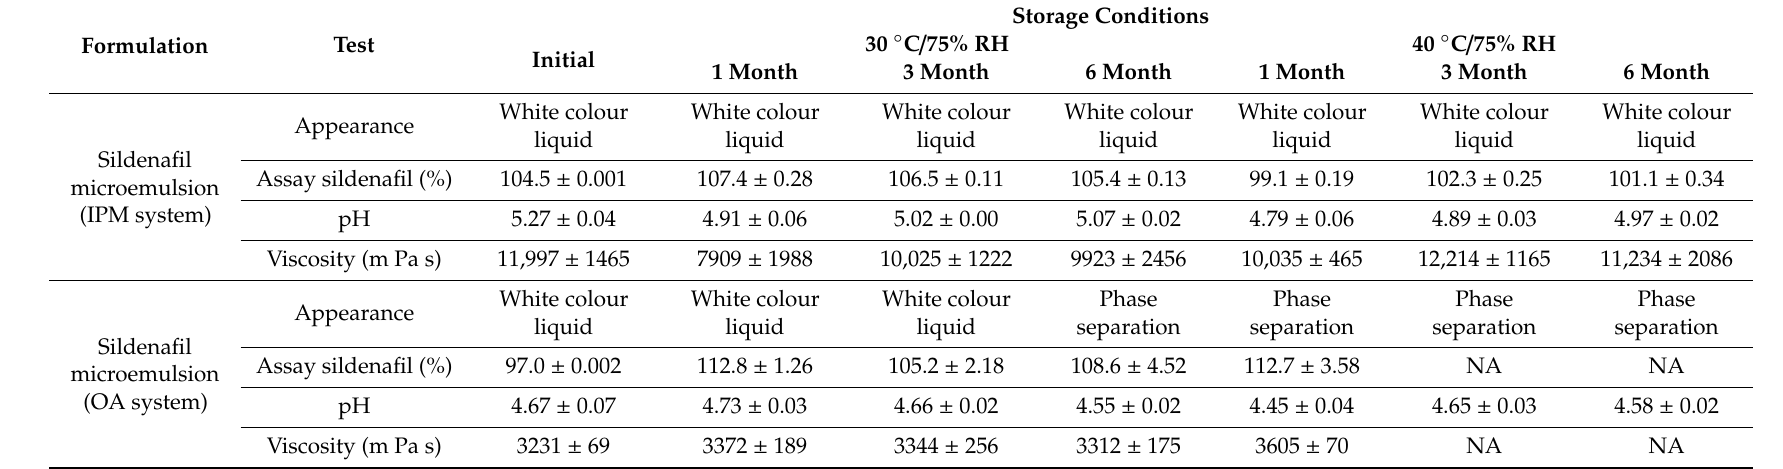
Table 6. Content of sildenafil citrate and stability of the sildenafil citrate microemulsion-loaded hydrogel at 30 ◦ C and 75% relative humidity (RH) and 40 ◦ C and 75% RH for 6